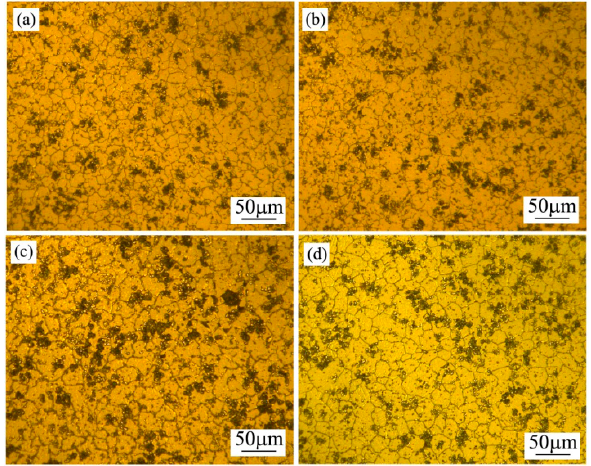
Figure 4. Optical microstructures of spray-casted AZ91D+0.75Ce alloy after being annealed at 420 ◦ C for different times: ( a ) 2 h; ( b ) 4 h; ( c ) 6 h; ( d ) 8 h.